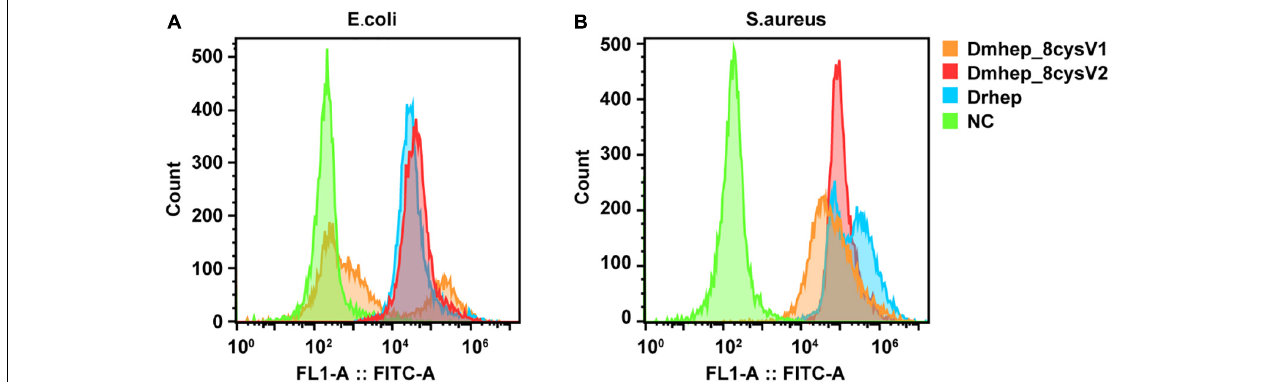
FIGURE 6 | Various hepcidin peptides were detected by flow cytometry to bind to E. coli (A) and S. aureus (B) . Orange represents Dmhep_8cysV1 (20 µ M), red represents Dmhep_8cysV2 (20 µ M), blue represents Drhep (20 µ M), and green represents NC (negative control,